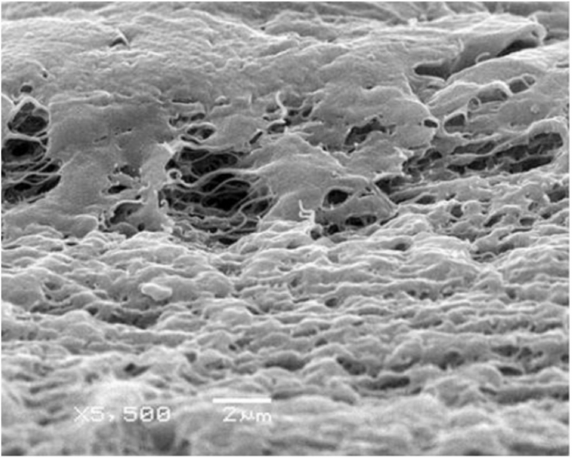
Figure 3. SEM image of the UHMWPE membrane prepared by stretching a monolithic film